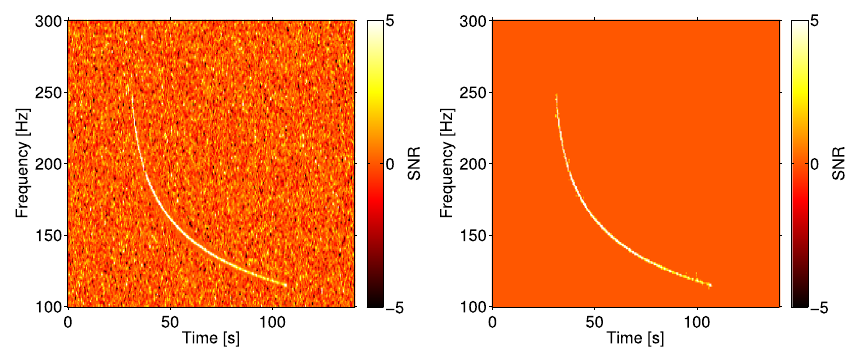
Fig. 69 Time-frequency maps for an injected long-duration transient gravitational-wave signal in noise. Left panel signal-to-noise ratio map before processing. Right panel signal-to-noise ratio map after applying a clustering algorithm. Note that the noise fluctuations have effectively been eliminated in the second plot. Images provided by Tanner